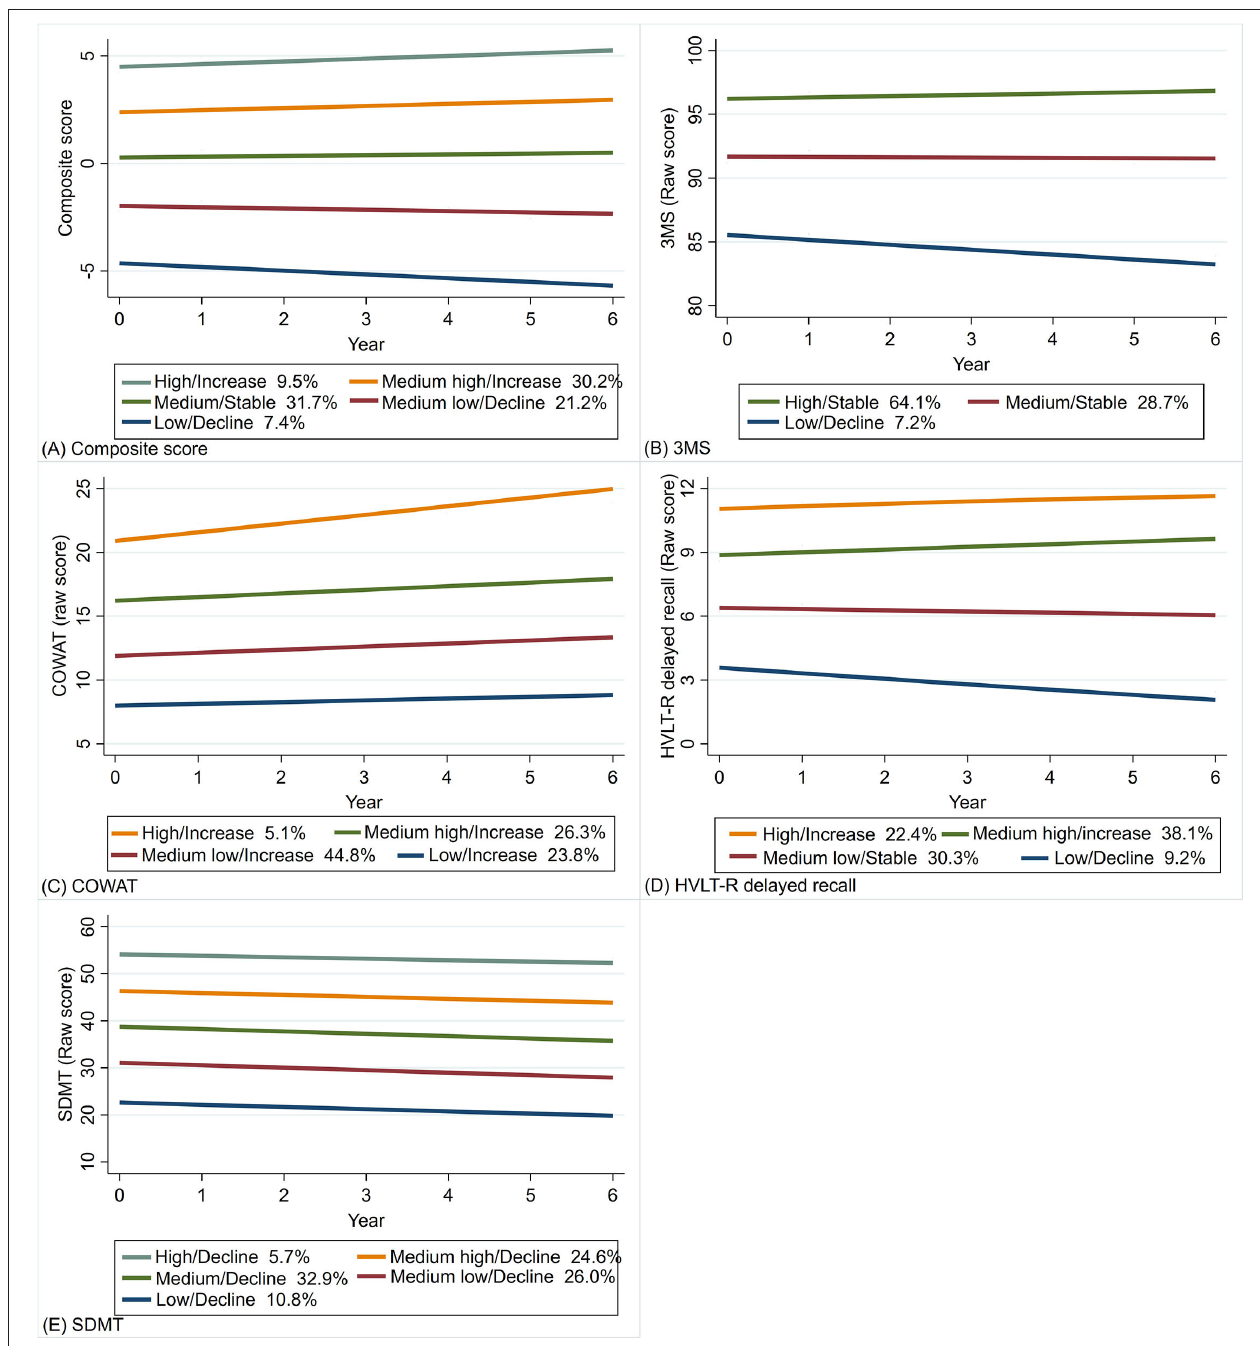
FIGURE 2 | Trajectory plots of the composite score (A) , and the raw scores of 3MS (B) , COWAT-F (C) , HVLT-R delayed recall (D) and SDMT (E) ( N = 16,174). (1) the x-axis denotes the year of cognitive assessment at baseline as well as 1, 3, 4, 5 and 6 years of follow-up; (2) the y-axis denotes the composite score and raw scores of the four cognitive tests; (3) the percentages refer to the proportions of participants assigned into the corresponding classes. 3MS, Modified Mini-Mental State Examination; COWAT-F, Controlled Oral Word Association Test-F; HVLT-R, Hopkins Verbal Learning Test–Revised (delayed recall); SDMT, Symbol Digit Modalities Test.